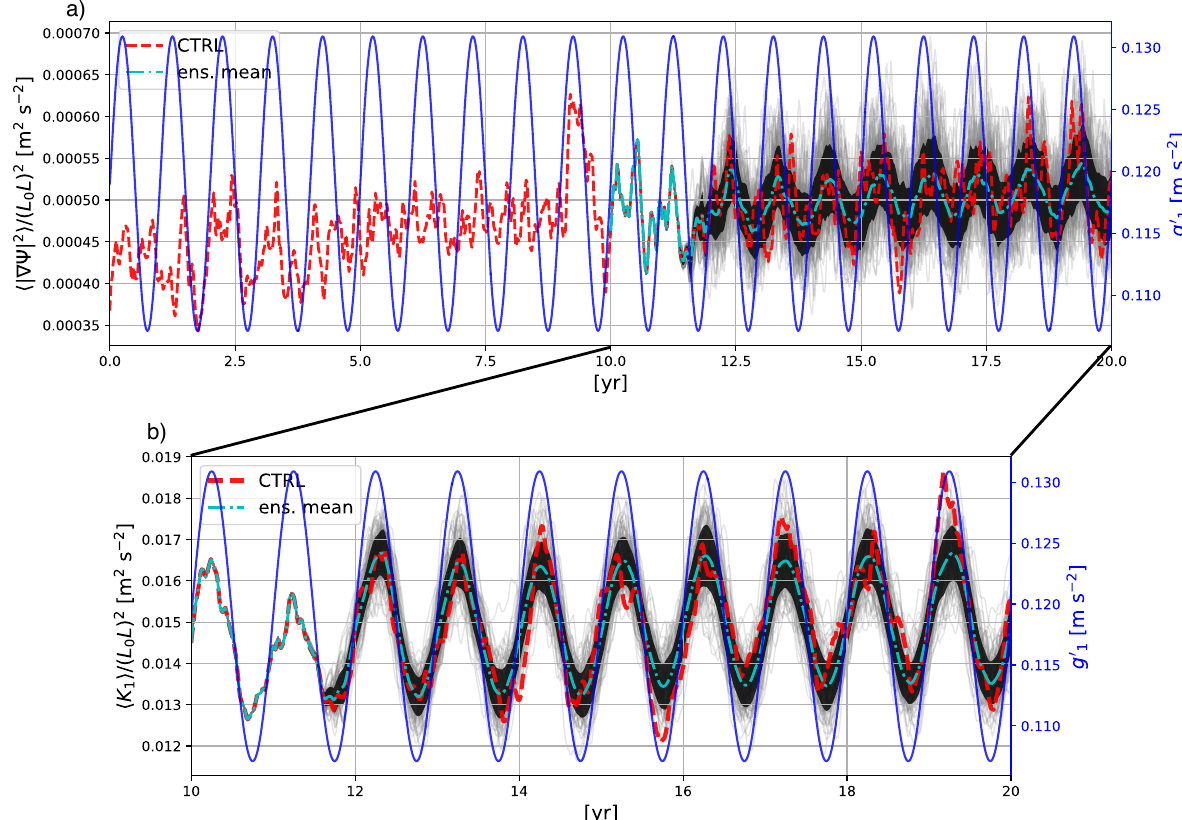
Figure 2. Time series of the horizontally averaged barotropic ( a ) and first-layer TKE ( b ). Each ensemble member is shown with thin gray lines and standard deviation of the ensemble mean in black shading. The CTRL run is shown with a red dashed line and ensemble mean with a cyan dot-dashed line. The reduced gravity is shown in blue plotted against the right y